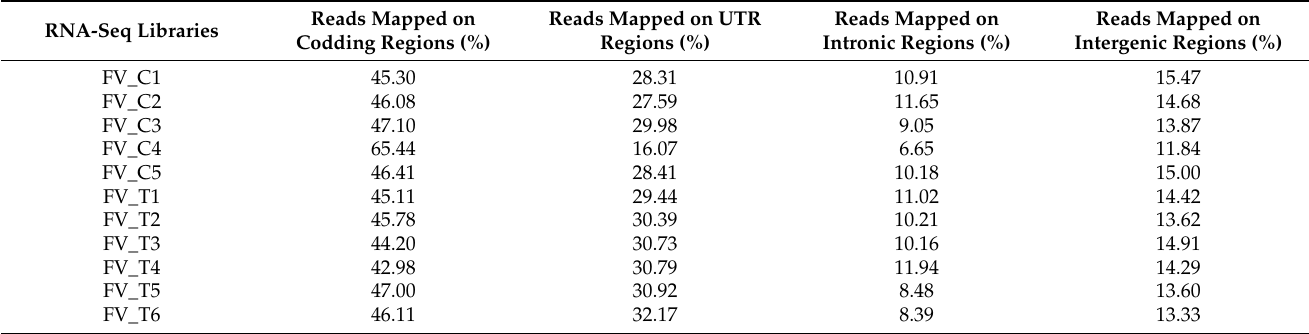
Table 2. Percentage of paired-end reads mapped to the genome. Reads were aligned according to the genomic localization; such a coding region represented by exons, untranslated region (UTR) represented by 5 (cid:48) and 3 (cid:48) UTR, introns and intergenic region located between the